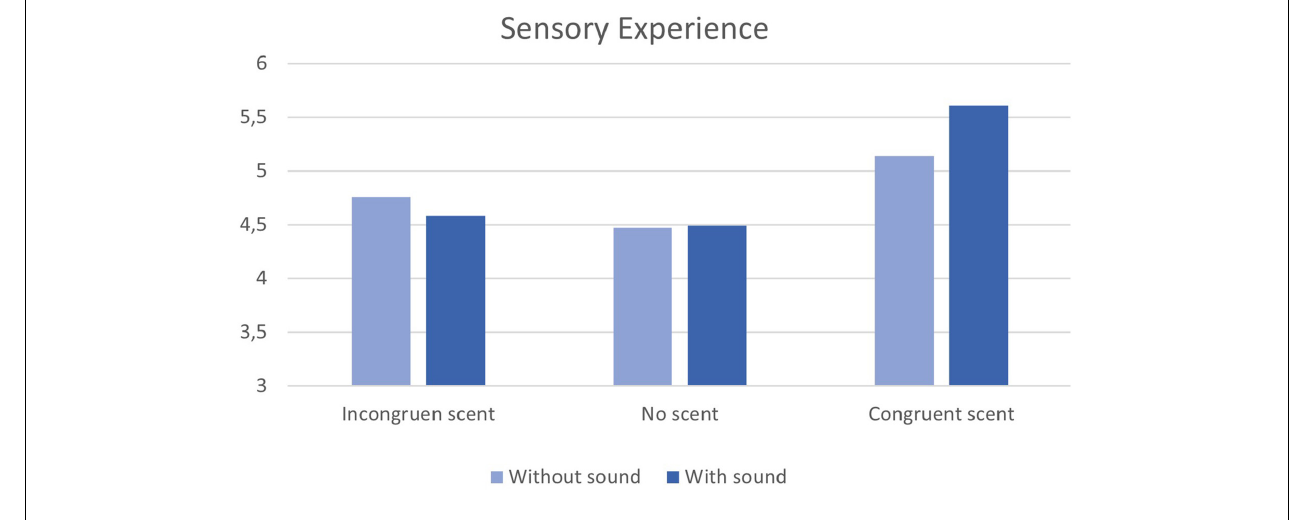
FIGURE 2 | Graphical overview of the mean “sensory experience” in the 6 experimental